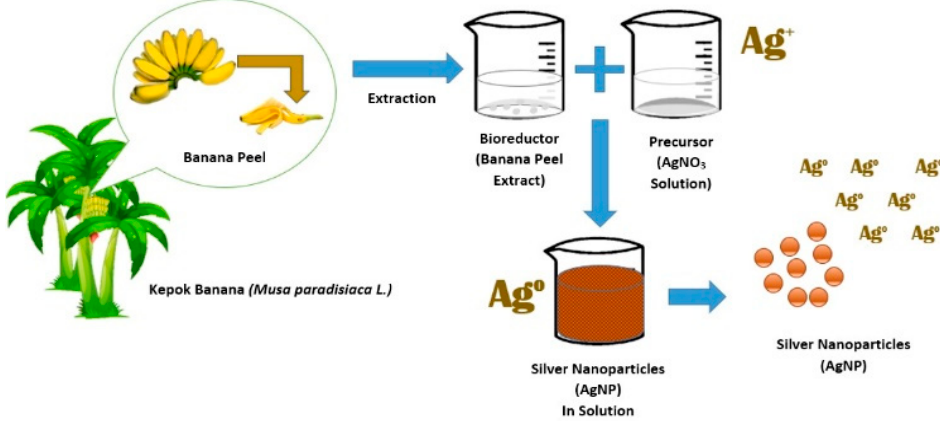
Figure 1. Ilustration of silver nanoparticle formation using banana peel extract as bioreductor.